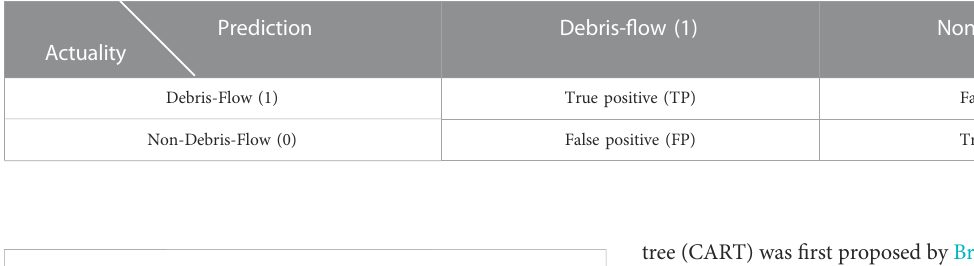
TABLE 4 Confusion matrix.